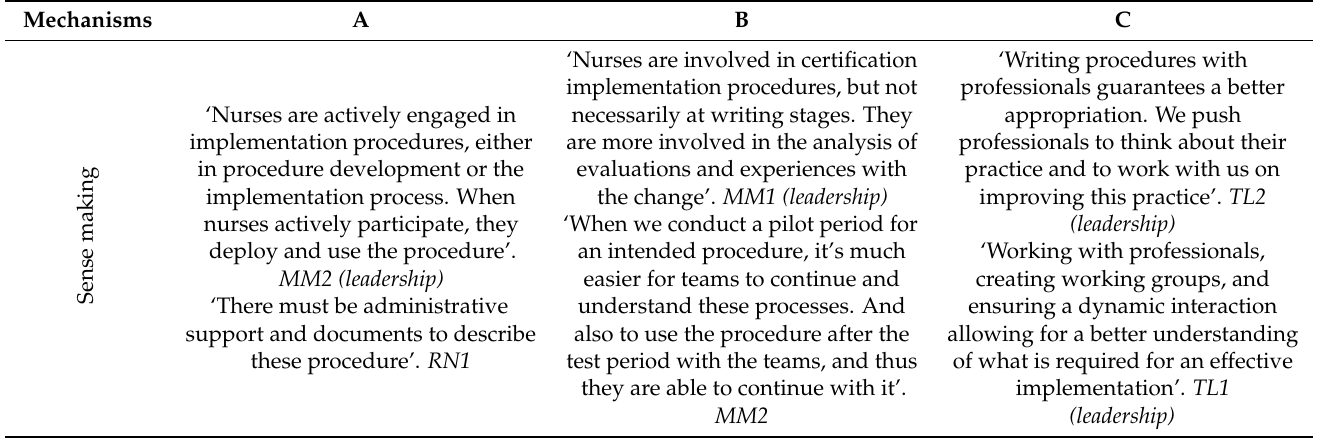
Table A4. Site (A, B and C) comparisons for sense-making, reflexive monitoring, and work articulation mechanisms with the